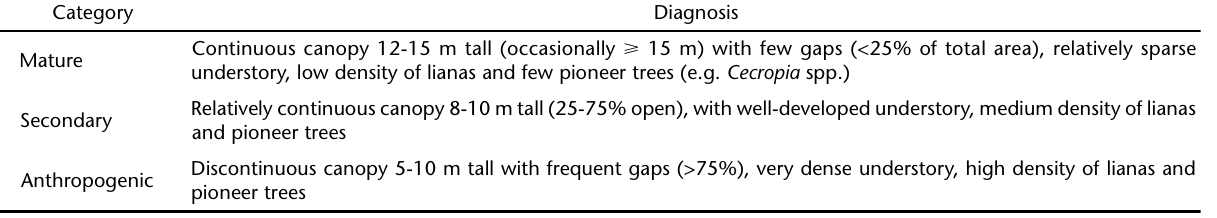
Table I. Habitat categories, adapted from C ALOURO & P IRES (2004), used to classify the vegetation along the trail system in each of the four forest fragments at the Fazenda Trapsa. Category Diagnosis Mature